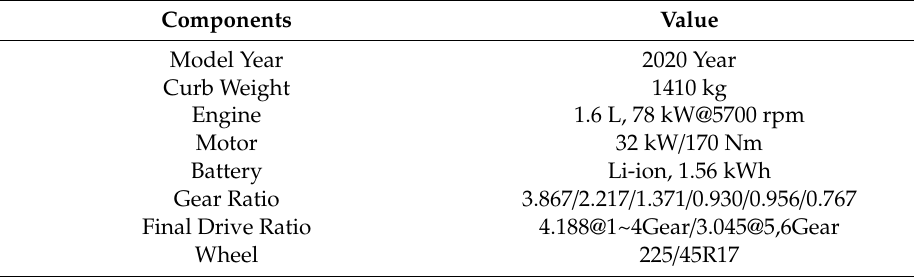
Figure 2. Powertrain System Configuration of Ioniq HEV. Table 1. Specifications of Ioniq